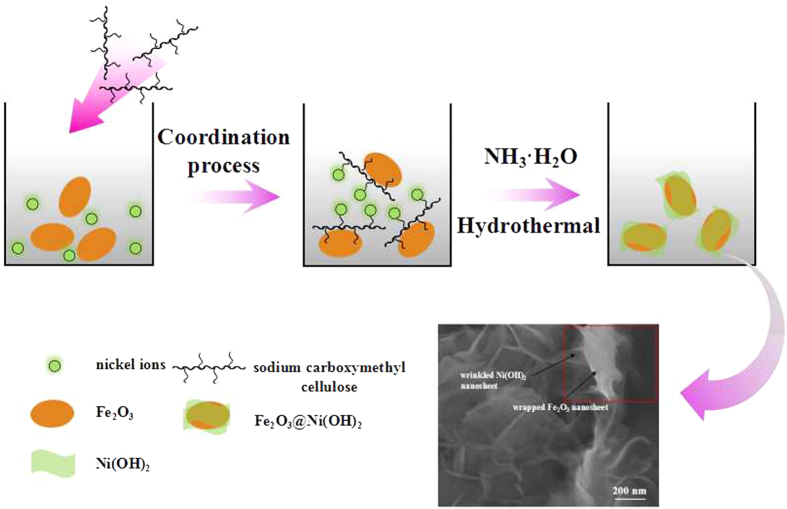
Schematic synthesis process of α-Fe2O3@Ni(OH)2 nanosheet hybrid.